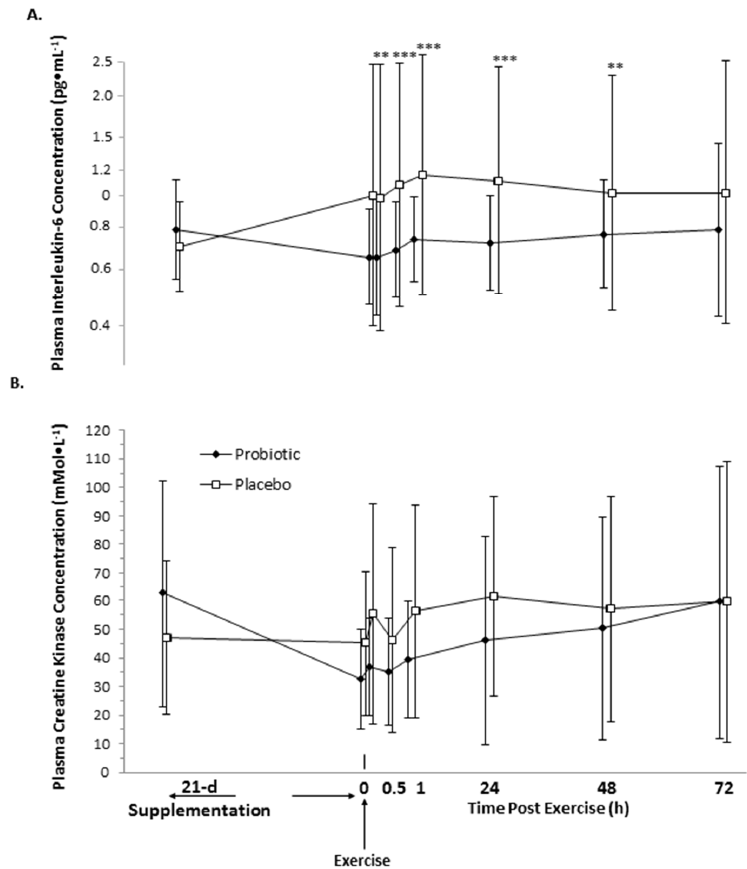
Figure 3. Effect of 21 days of probiotic and placebo supplementation on plasma ( A ) interleukin ‐ 6 and ( B ) creatine kinase concentrations. For IL ‐ 6, means were generated from log ‐ transformed values and presented on a log scale to manage the heterogeneity of error. Means and SD for creatine kinase concentration are raw. The probability of substantial standardized effect of probiotic–placebo, relative to the baseline is included above the contrast represented as ** likely, *** very likely; contrasts with no stars are inconclusive or unclear. All probiotic–placebo post–pre exercise contrasts were unclear [24].